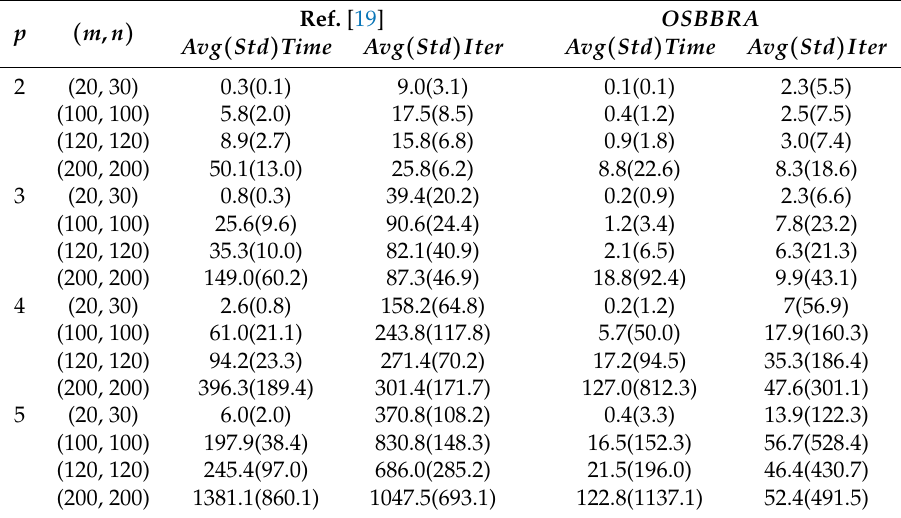
Table 8. Computational results on (LMP3) and comparison with results reported in [19].